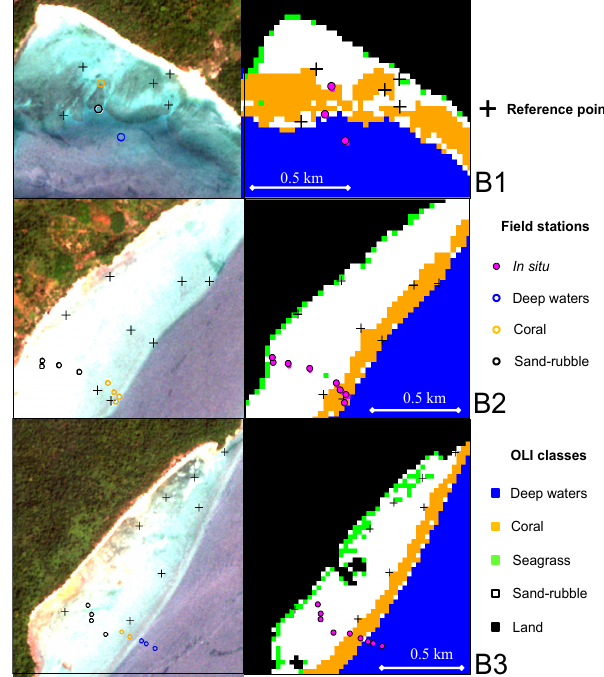
Figure 7. Comparison between RapidEye true-colour images (on the left) and classification results (on the right, from OLI data) obtained in three bays in the southern part of Lampi Island. Location of the bays is shown in Figure 5. Crosses identify the same coordinates in both images; circles and dots correspond to in situ stations.